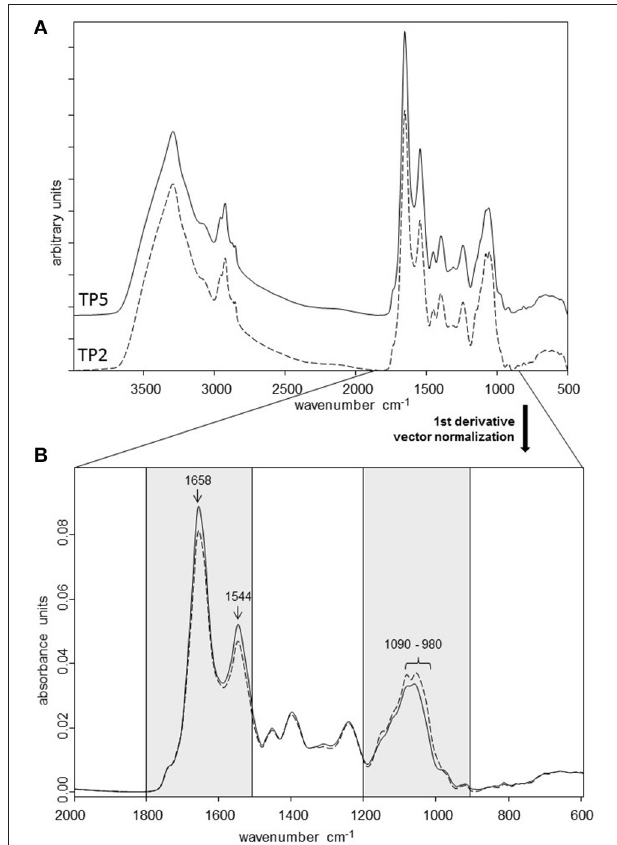
FIGURE 2 | (A) FTIR spectra from TP2 and TP5 recorded in the transmission mode at 4,000 to 500 cm − 1 . First derivative, normalized average FTIR spectra of three independent measurements of TP2 and TP5. (B) Spectra are shown from the spectral range with the most pronounced differences between the two strains (amide/protein region: 1,800 to 1,500 cm − 1 ; polysaccharide region: 1,200 to 900 cm − 1